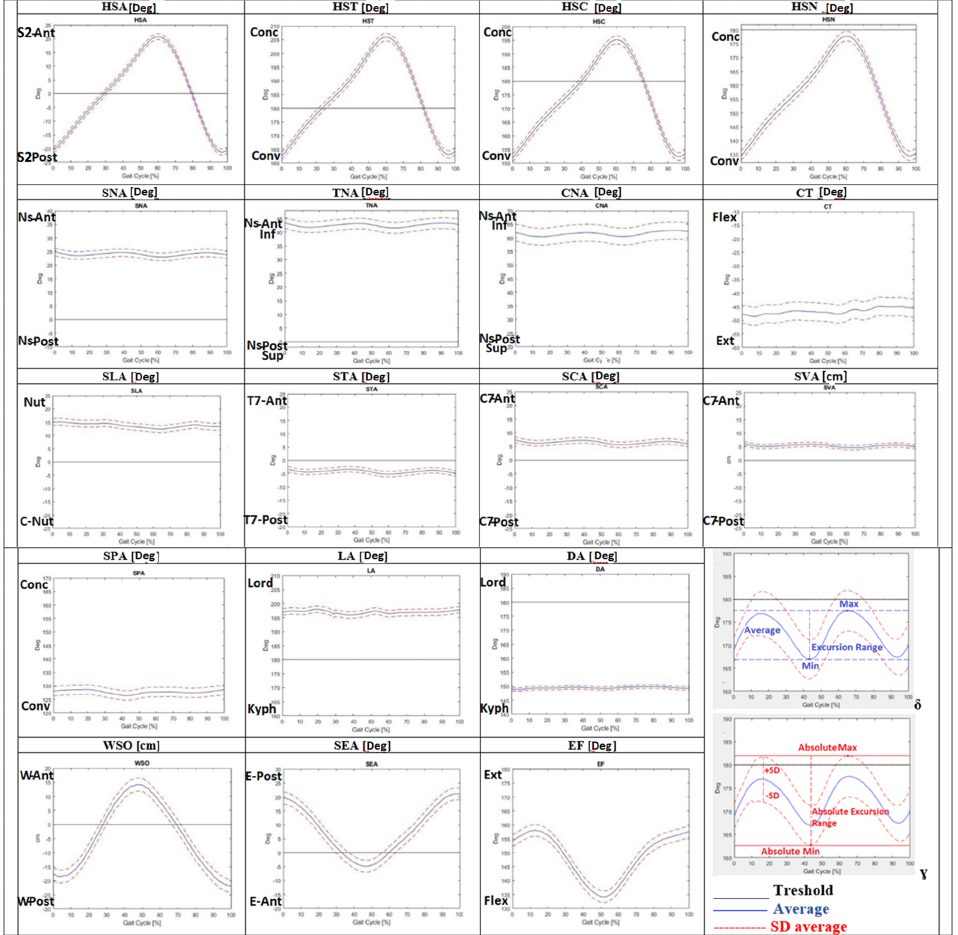
Figure 2. Average of kinematic curves during the gait cycle for eighteen new sagittal DB-Total [14] parameters. Graphs δ and G explain the new kinematic DB-Total values: Average, Excursion Range, Absolute Excursion Range, Minimum (Min), Maximum (Max), Standard Deviation (SD), and Absolute Minimum (Min) and Maximum (Max). The scale range of the graph was set to 50 (degrees or cm) in order to highlight different inter-subject variability. Dorsal Angle (DA), Lumbar Angle (LA), Elbow Flexion (EF), Shoulder–Elbow Angle (SEA), Sagittal Vertical Axis (SVA), Wrist–ASIS Offset (WSO), C7–Nasion Angle (CNA), T7–Nasion Angle (TNA), S2–Nasion Angle (SNA), S2–C7 Angle (SCA), S2–T7 Angle (STA), S2–L5 Angle (SLA), He–S2 Angle (HAS), He–S2–Ns Angle (HSN), He–S2–C7 Angle (HSC), He–S2–T7 Angle (HST), Spinal–Pelvic Angle (SPA), nasion (Ns), wrist (W), elbow (E), posterior (Post), anterior (Ant), dorsiflexion (Dors), plantiflexion (Plant), flexion (Flex), extension (Ext), adduction (Add), abduction (Abd), kyphosis (Kyph), lordosis (Lord), nutation (Nut), counter nutation (CNut), concavity (Conc), convexity